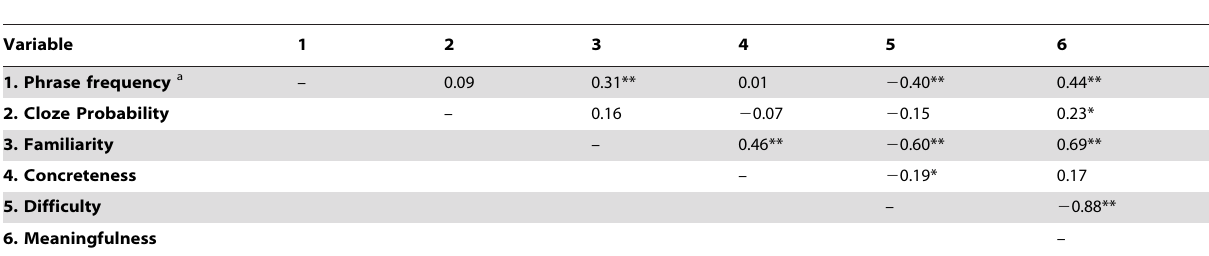
Table 3. Spearman’s correlation coefficients in Experiment 1 (out of context